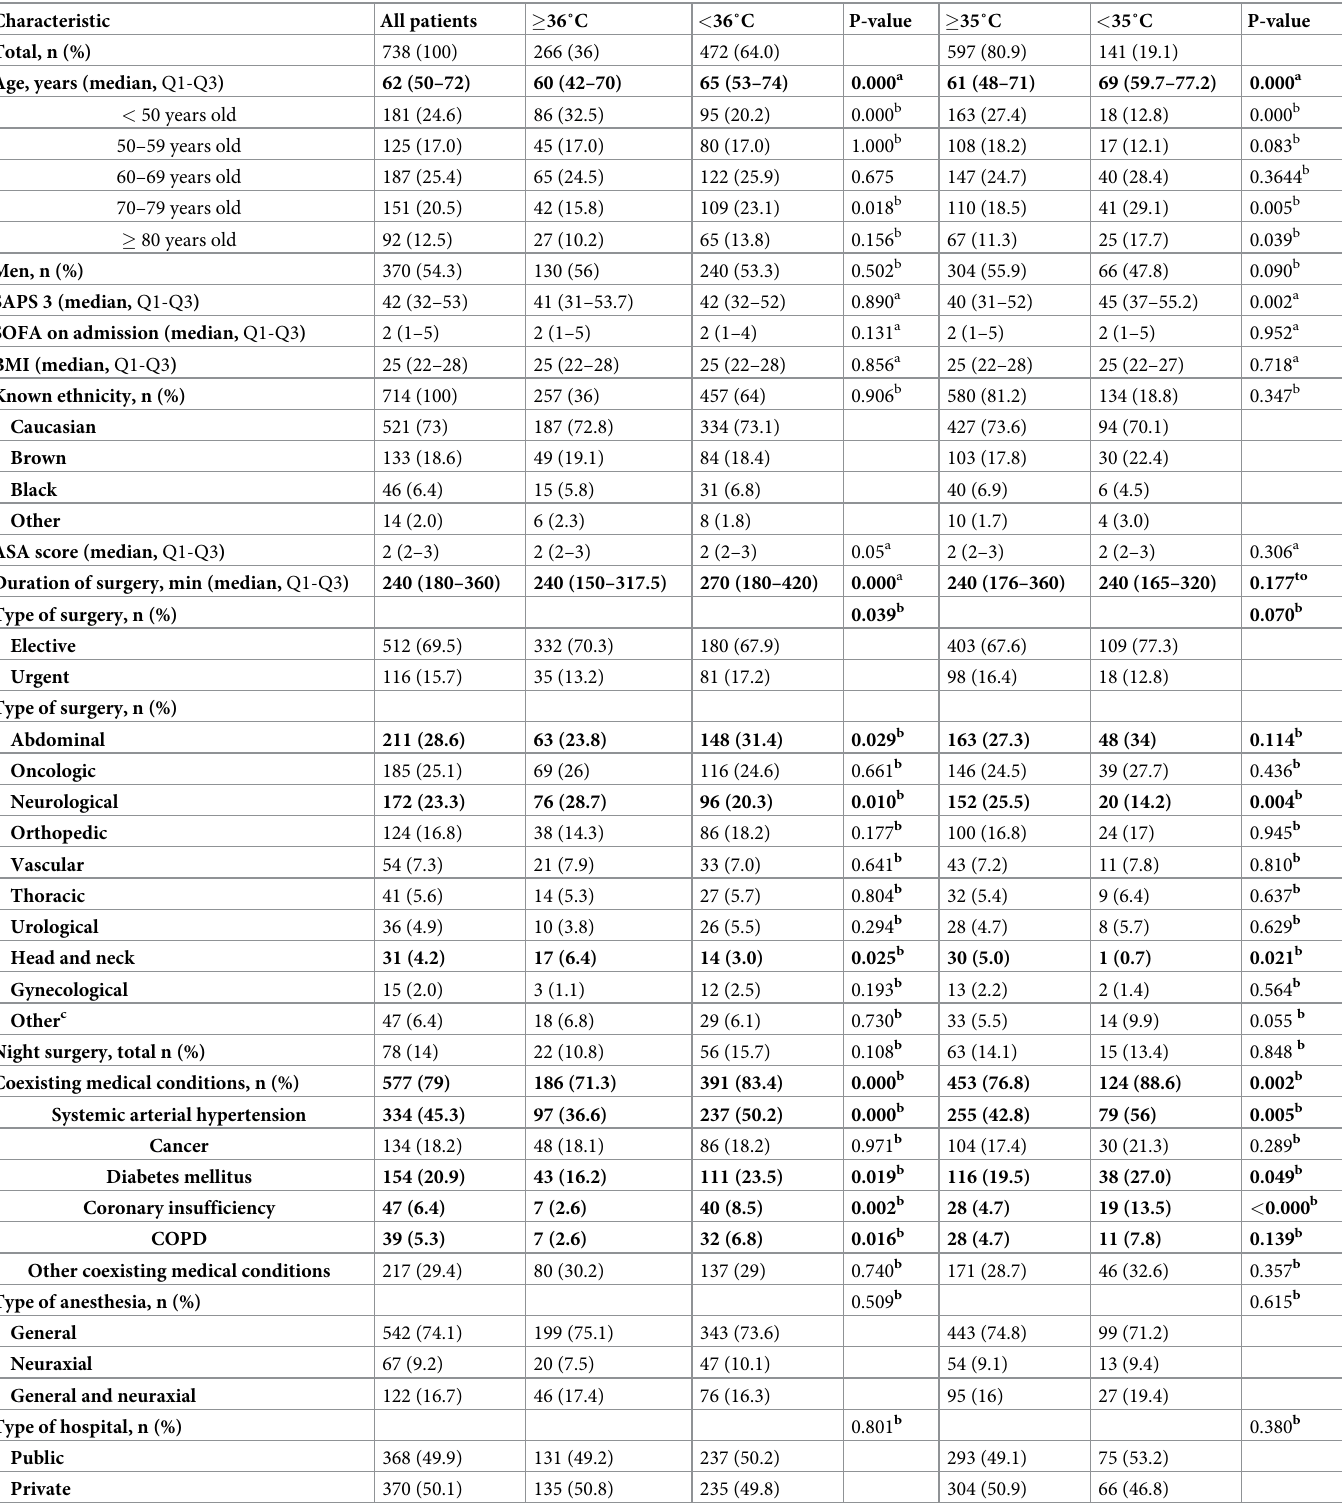
Table 1. Characteristics of patients with and patients without postoperative